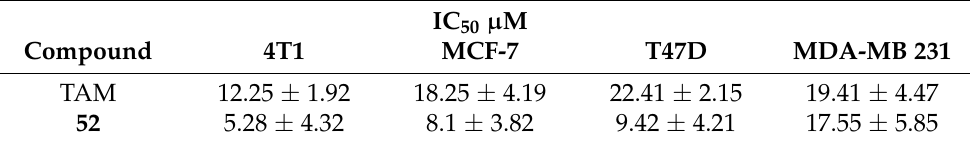
Scheme 7. Synthesis of CA-TAM hybrid. Reaction conditions: (a) DCM, TFA, 6 h, r.t. Table 6. IC 50 ( µ M) Values of TAM and CA-TAM conjugate 52 with respect to TAM equivalent Table 6. IC 50 (µM) Values of TAM and CA-TAM conjugate 52 with respect to TAM equivalent concentrations in different ER +ve and ER − ve cancer cell concentrations in di ff erent ER +ve and ER − ve cancer cell lines.